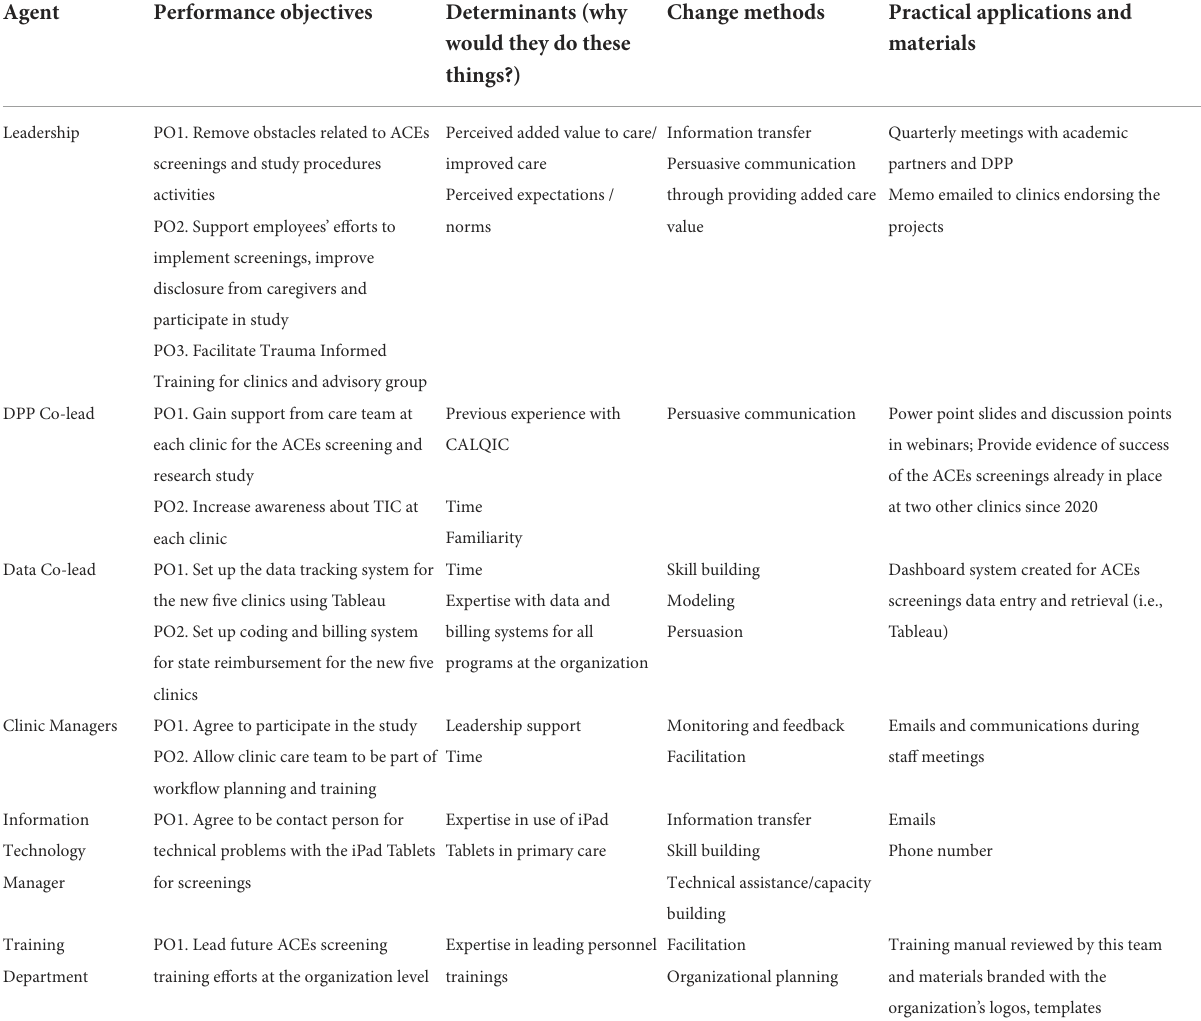
TABLE 3 Implementation Mapping: Steps 3 and 4. Preparation